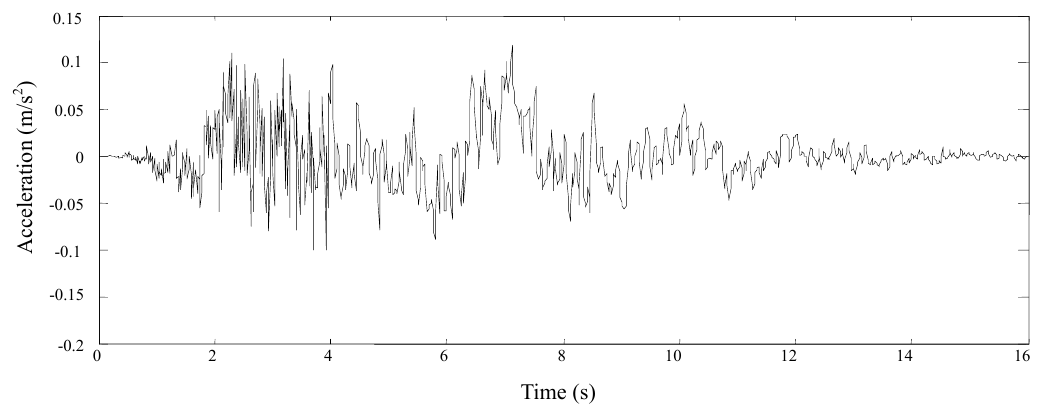
Fig. 9. Synthesized seismic acceleration time-history (site = type